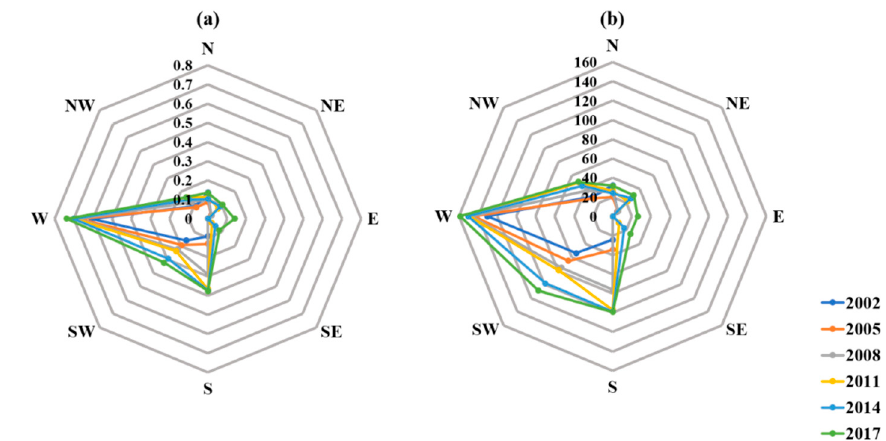
Figure 8. The variations of the urban heat island ratio index (URI) and hot thermal landscape area in eight sub-regions from 2002 to 2017. ( a ) URI; ( b ) Hot thermal landscape.